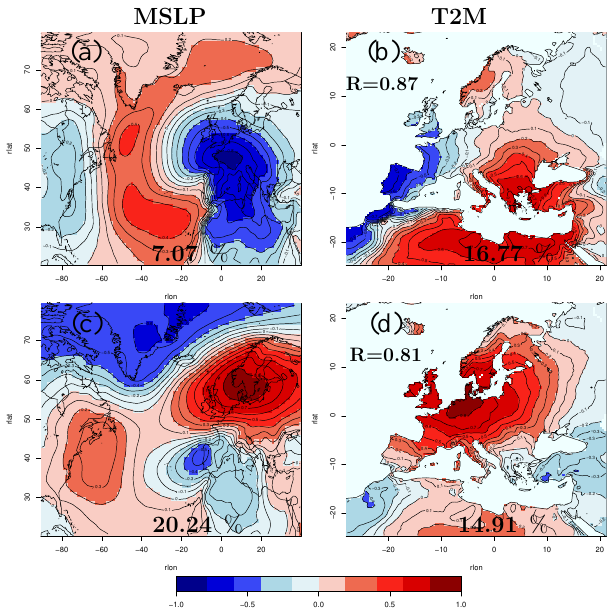
Figure 11. As in Fig. 10 but for Summer